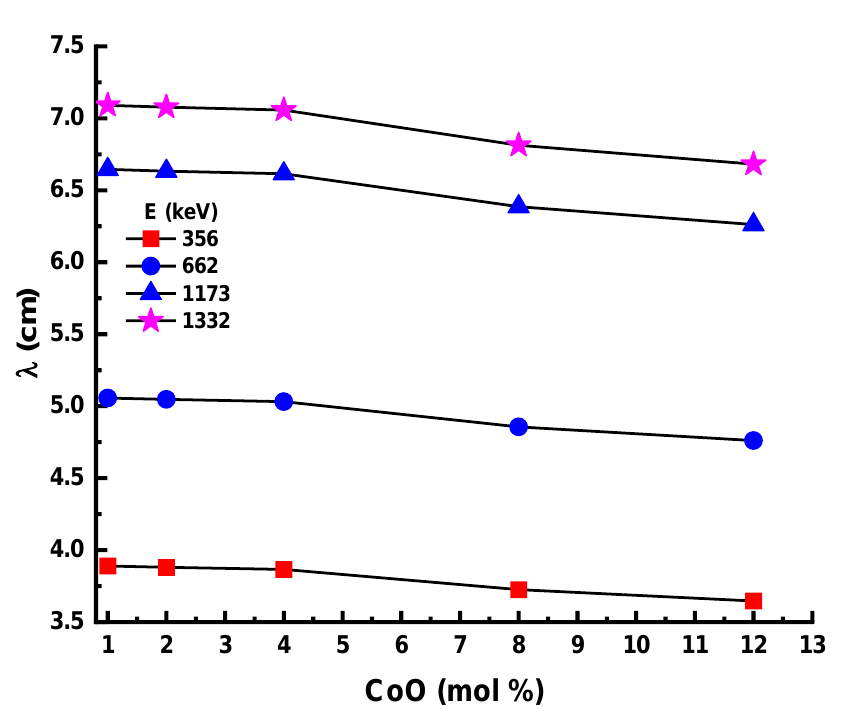
Figure 12. Experimental mean free path (λ) for glass samples.